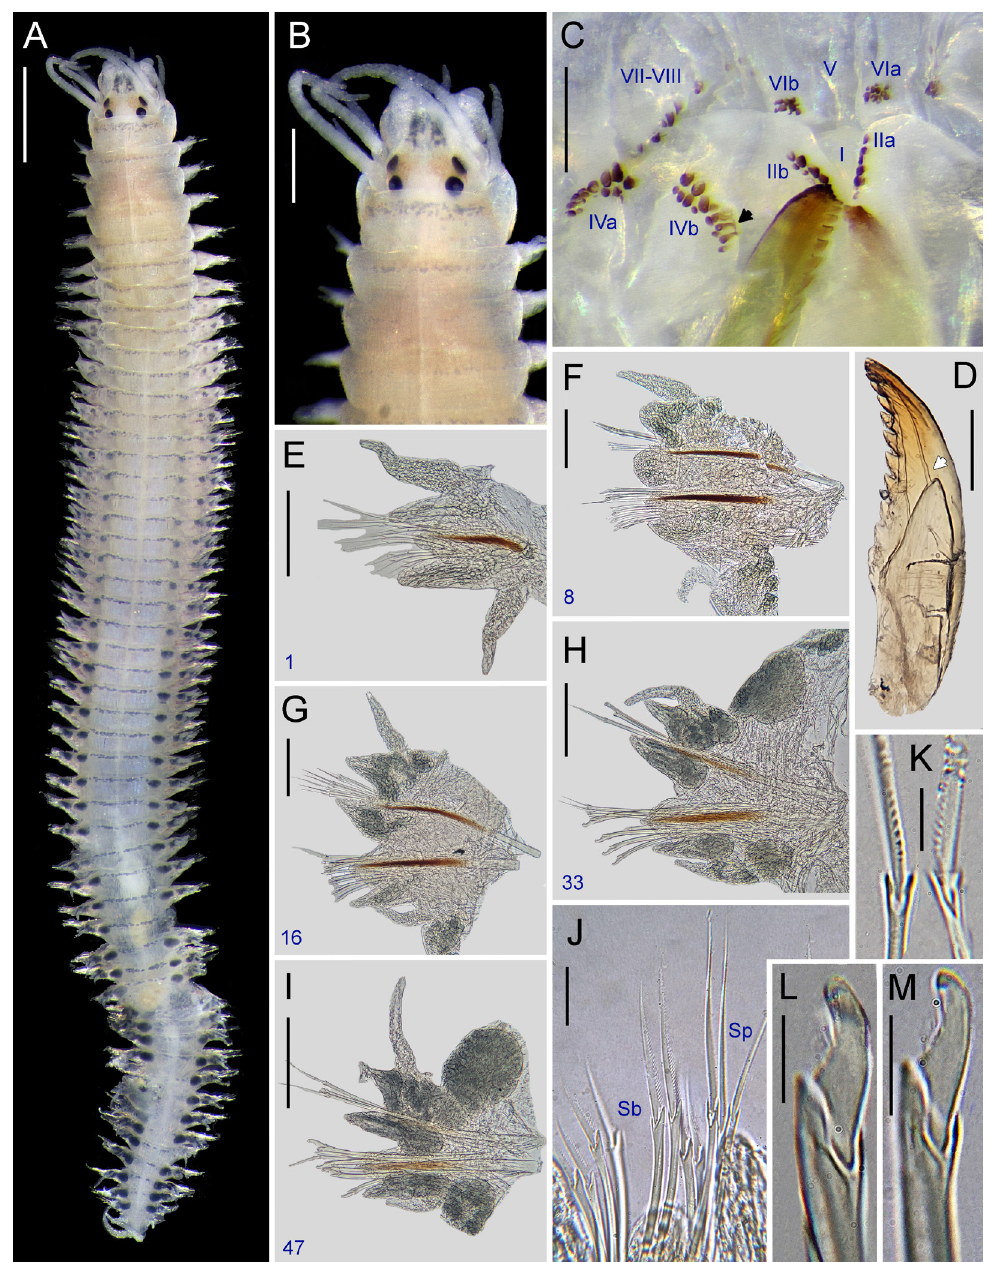
Fig. 2. Neanthes galetae Fauchald, 1977. A–B, E–M . Holotype (USNM 53088) from Galeta Reef, Panama, atokous. C–D . Paratype (USNM 53089) from Galeta Reef, Panama, atokous. A . Entire body in dorsal view. B . Anterior end in dorsal view. C . Non-everted pharynx in ventral view, black arrow indicates merged paragnaths. D . Right jaw in dorsal view, white arrow indicates canals. E . Right parapodium from chaetiger 2 in anterior view. F . Right parapodium from chaetiger 8 in anterior view. G . Right parapodium from chaetiger 16 in anterior view. H . Right parapodium from chaetiger 33 in anterior view. I . Right parapodium from chaetiger 47 in anterior view. J . Supracicular (Sp) and subacicular (Sb) neurochaetae (chaetiger 1). K . Homogomph spiniger from supracicular neurochaetae (chaetiger 47). L . Heterogomph falciger from supracicular neurochaetae (chaetiger 47). M . Heterogomph falciger from subacicular neurochaetae (chaetiger 47). Roman numerals refer to the areas and Arabic numbers to chaetigers. Scale bars: A = 0.5 mm; B = 0.2 mm; C–I = 0.1 mm; J = 20 µm; K–M = 10